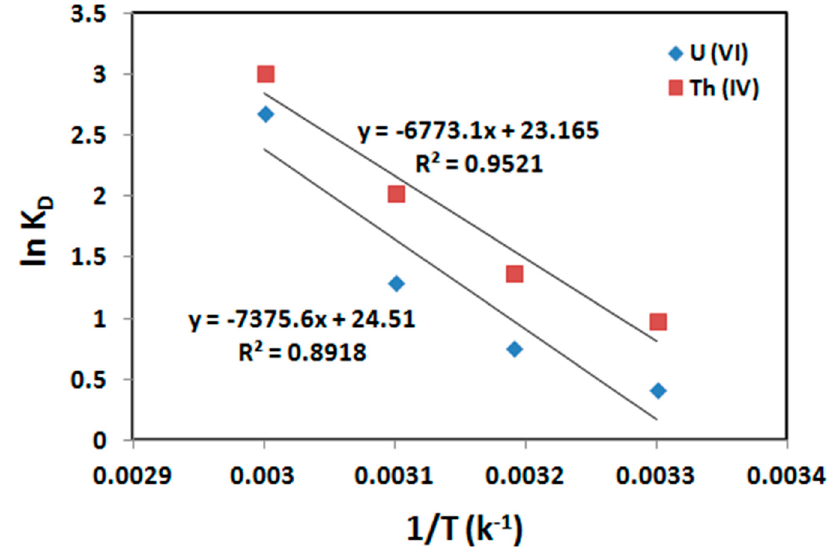
Figure 15. Variation of ln K D with 1/ T for sorption of U(VI) and Th(IV) onto HQ-bentonite. Table 4. Values of thermodynamic parameters of U(VI) and Th(IV) ions sorption onto HQ-bentonite.